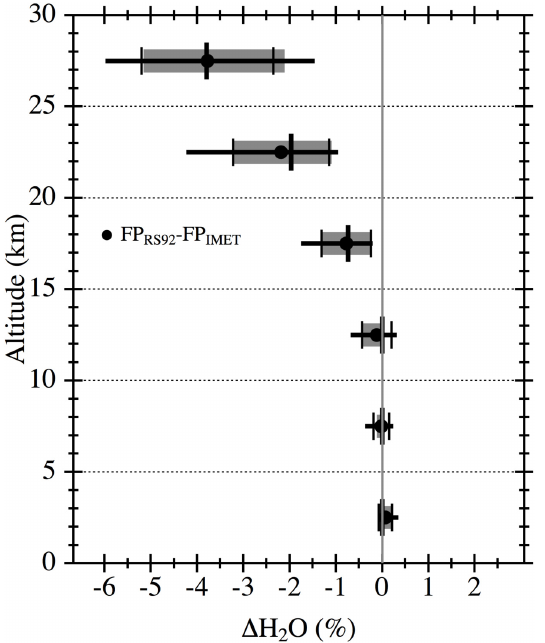
Fig. 17. Statistics of 1 H 2 O present the relative differences between water vapor mixing ratios calculated from frost point hygrometer measurements using independent P measurements by RS92 sondes (FP RS92 ) and iMet sondes (FP IMET ), in 5-km altitude bins. Each of the symbols represents the same statistics of differences described for Fig. 5. The 1 H 2 O have statistically significant negative bi- ases above 15km that result from positive biases in RS92-iMet 1P above 15km (Fig. 9).